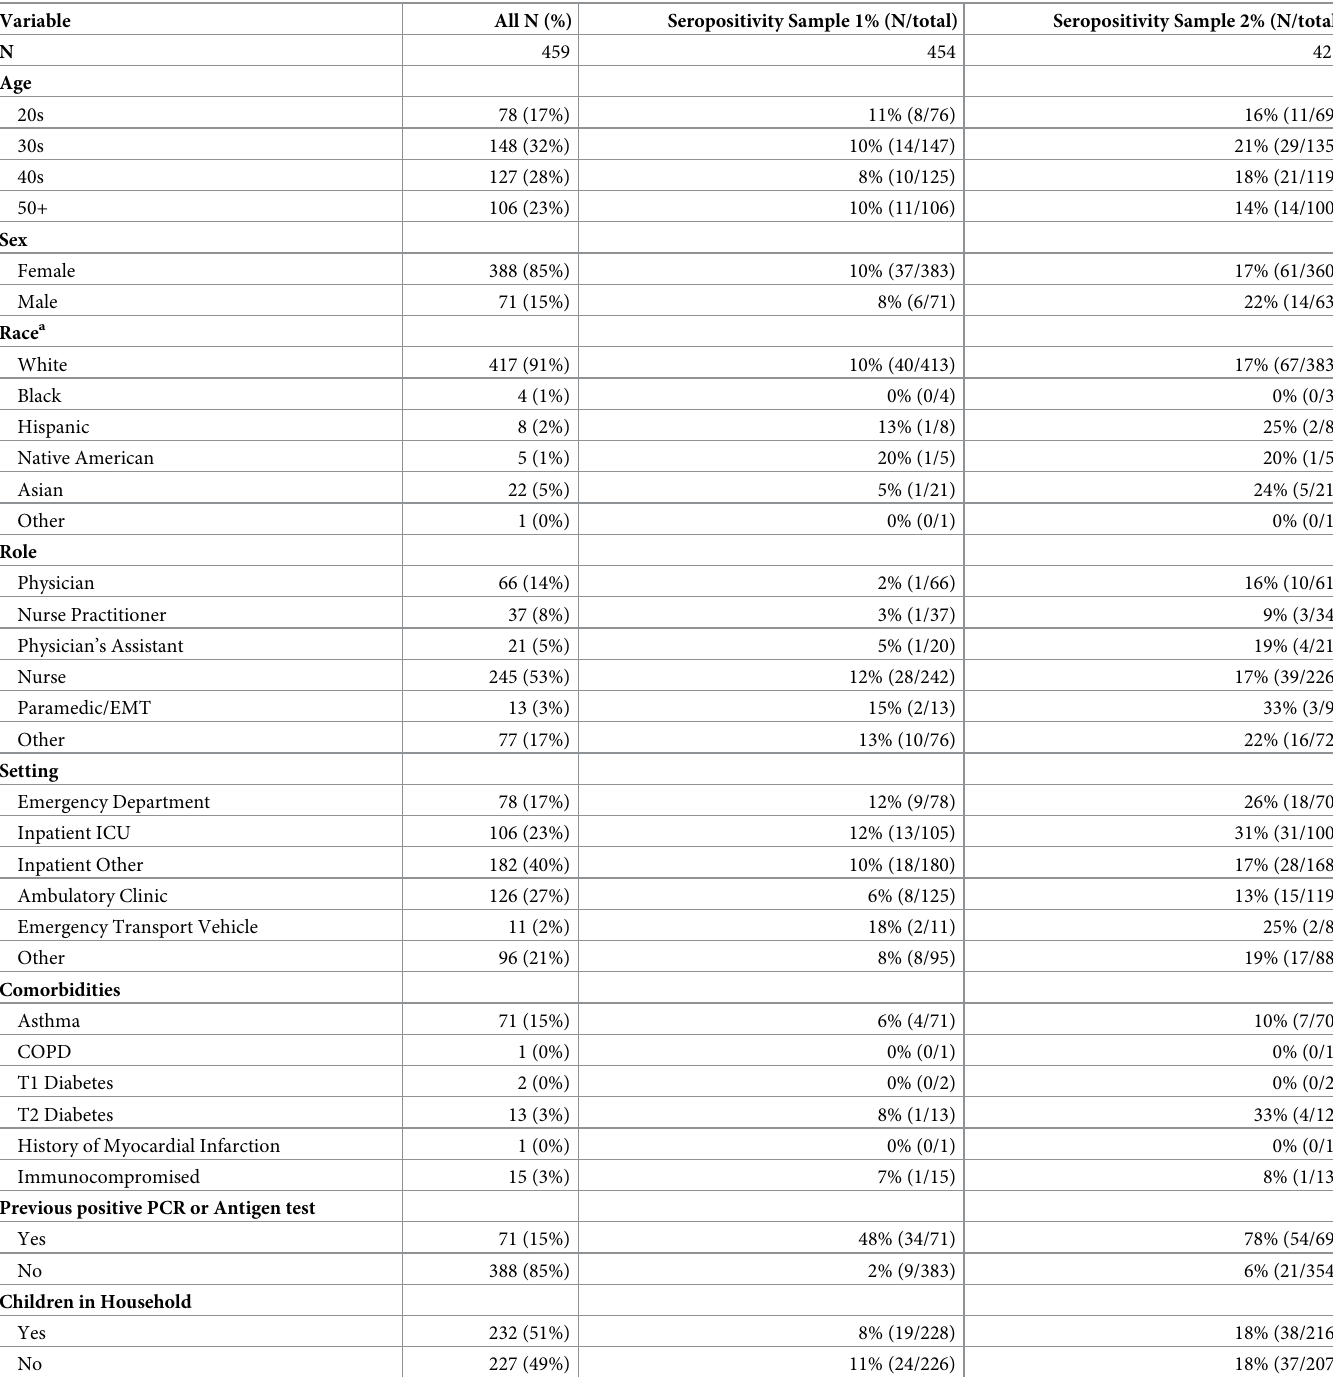
Table 1. General participants characteristics and seroprevalence among each